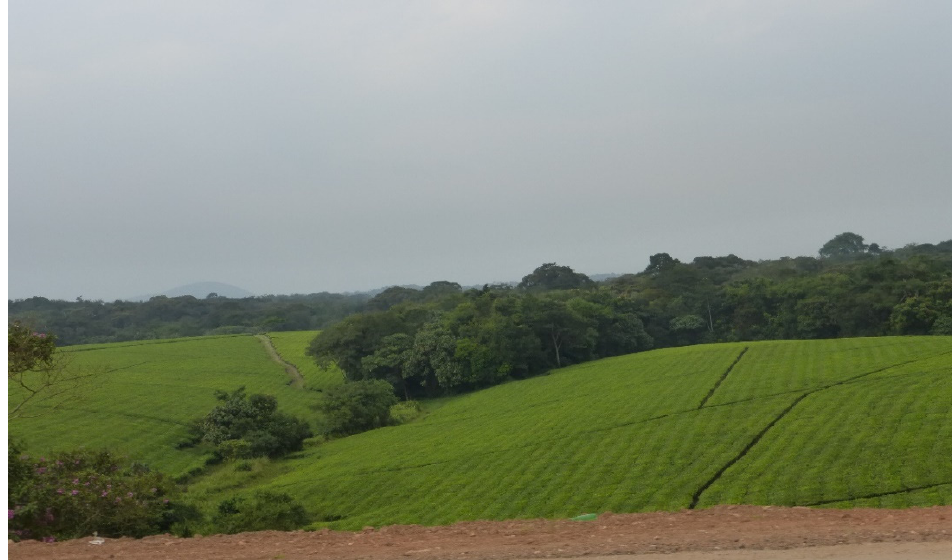
Figure 1. Deforested rainforests for tea (own).